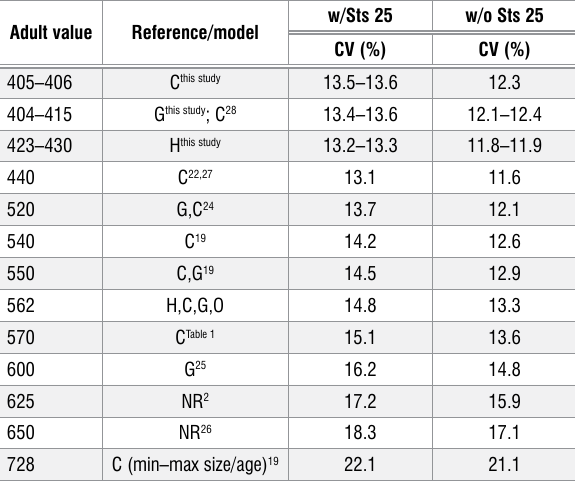
Coefficient of variation (CV) estimates for the Australopithecus